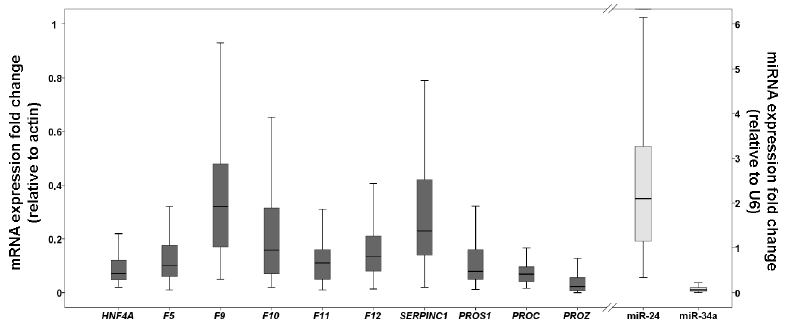
Fig 1. Hepatic expression profiles of mRNAs and miRNAs in human liver samples. Box plots indicate first and third quartiles of expression; the bold line in the box represents the median value; the whiskers represent the range.